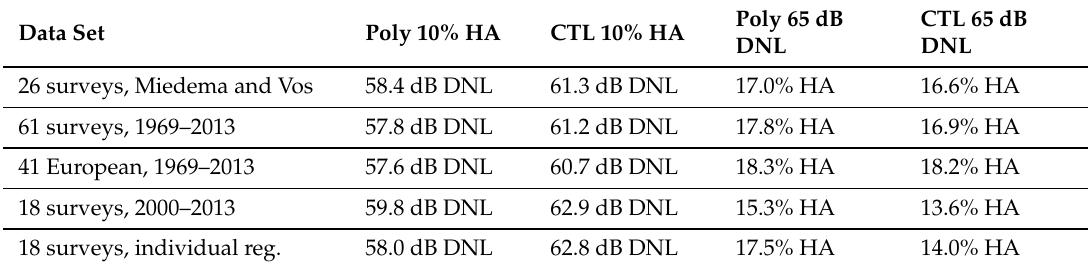
Table 2. Comparison of the analysis results from di ff erent selections of